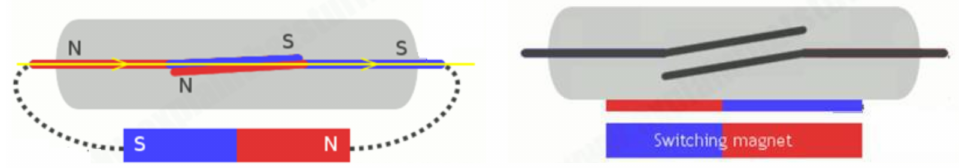
Figure 1. Example of making magnetic contacts on the left type of normally open (NO), on the right type of normally closed